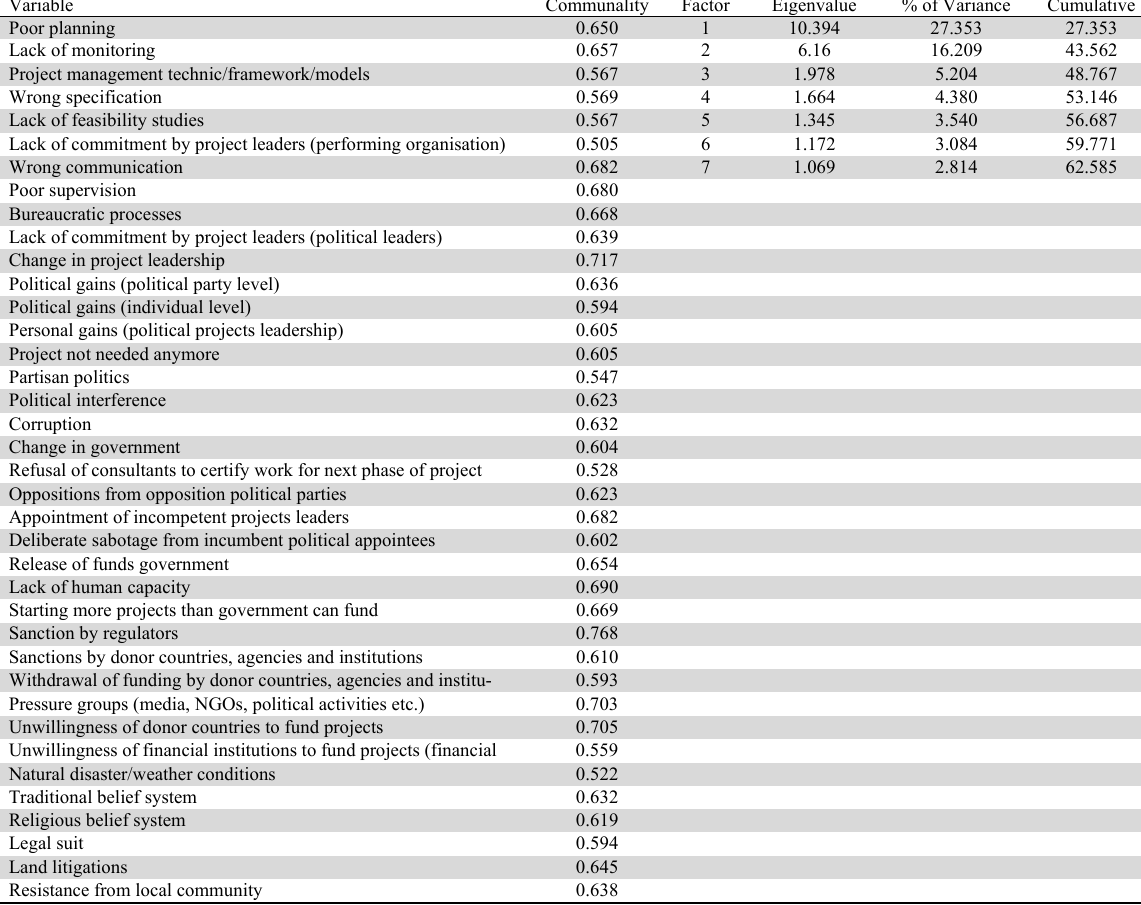
Principal Component